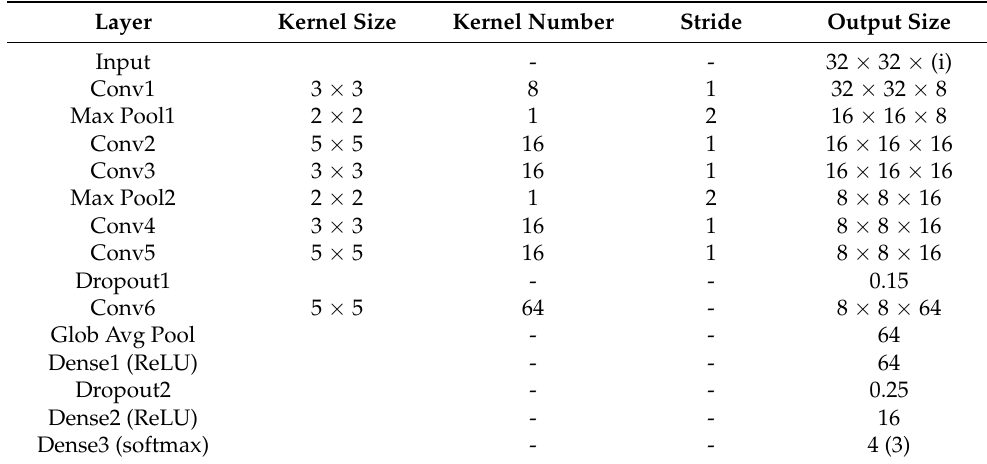
Table 2. Configuration of Saf/Safaugu CNN model. (i) is the number of input bands. We classified into 4 or 3 disturbance classes.